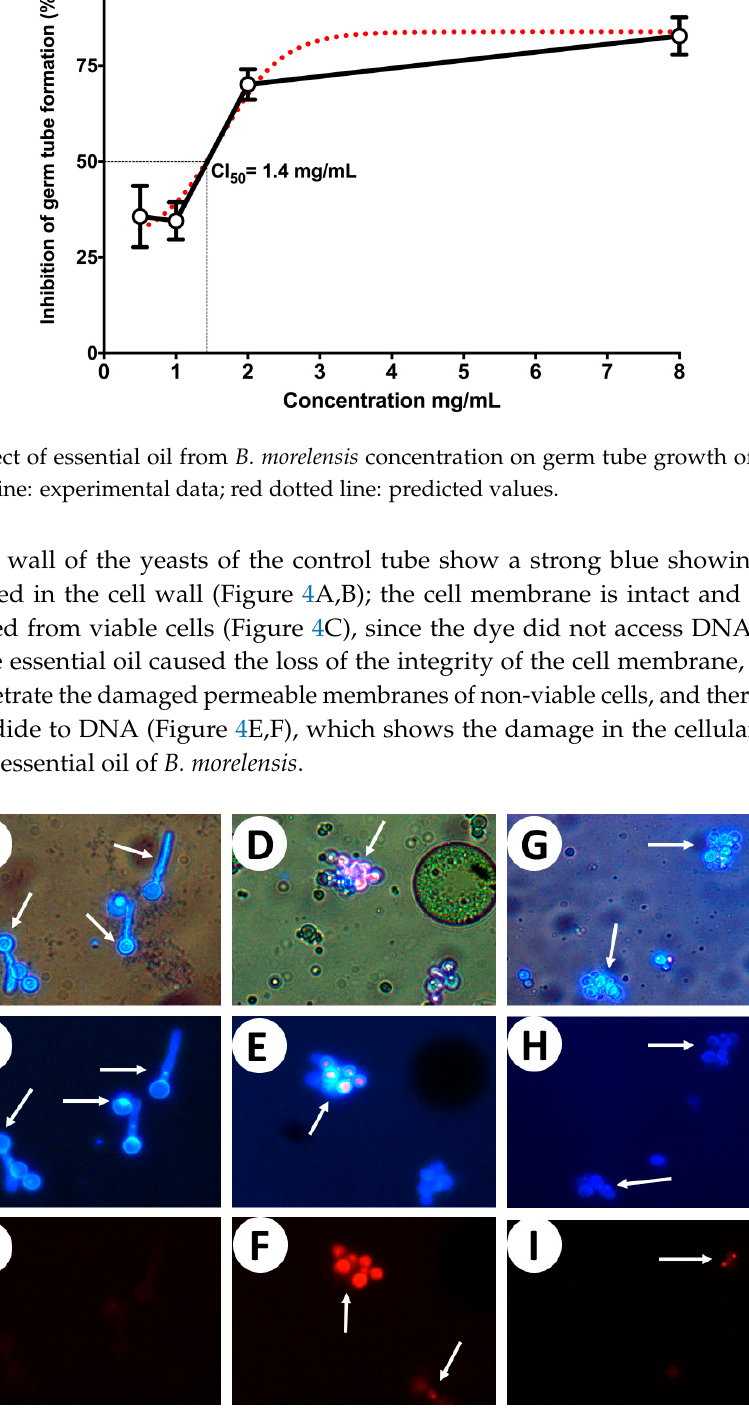
Figure 2. Germ tube growth after two hours of activation with fetal bovine serum with addition of ( A ) Control without essential oil; ( B ) Essential oil at a concentration of 8.0 mg/mL, which resulted in a decreased ability of the yeast to develop a germ tube; ( C ) Essential oil at a concentration of 0.5 mg/mL, with many yeast having normal germ tube growth, but some having poor growth. Arrows indicate the germ tube growth. Microphotographs were taken at 40×.